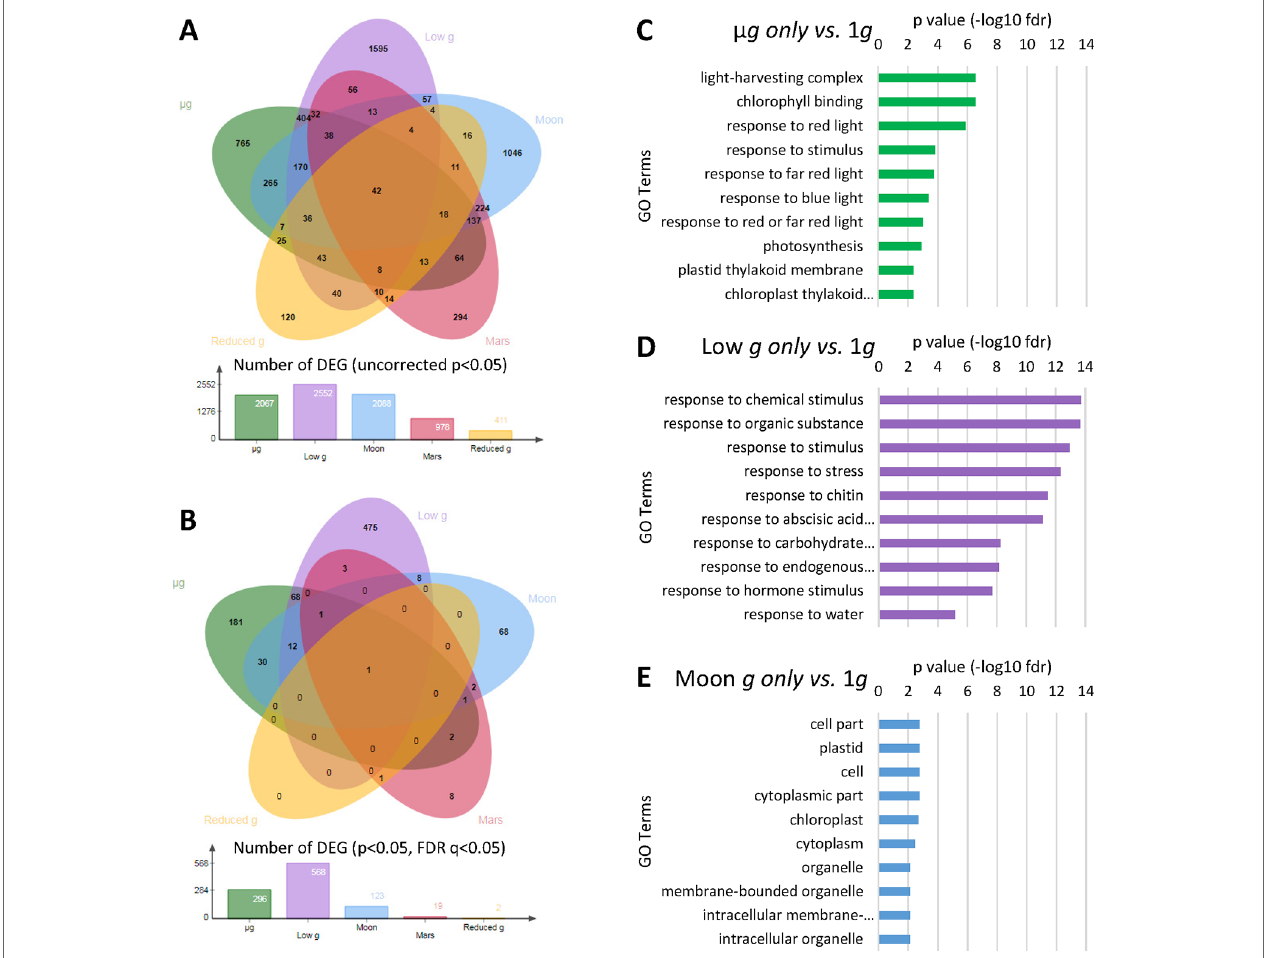
FIGURe 2 | Differentially expressed genes (DEGs) across the different gravity levels. (A) Venn diagram classifying DEGs using uncorrected p-value (p < 0.05). (B) Venn diagram classifying DEGs including an adjusted FDR q-value (p and q < 0.05). (c) Ten most significant gene ontology (BinGO GO Full Enrichment) categories from DEG in µ g vs. 1 g only (FDR q < 0.05). (D) Ten most significant gene ontology (BinGO GO Full Enrichment) categories from DEG in low gravity (circa 0.1 g ) vs. 1 g only (FDR q < 0.05). (e) Ten most significant gene ontology (BinGO GO Full Enrichment) categories from DEG in Moon gravity vs. 1 g only (FDR q <